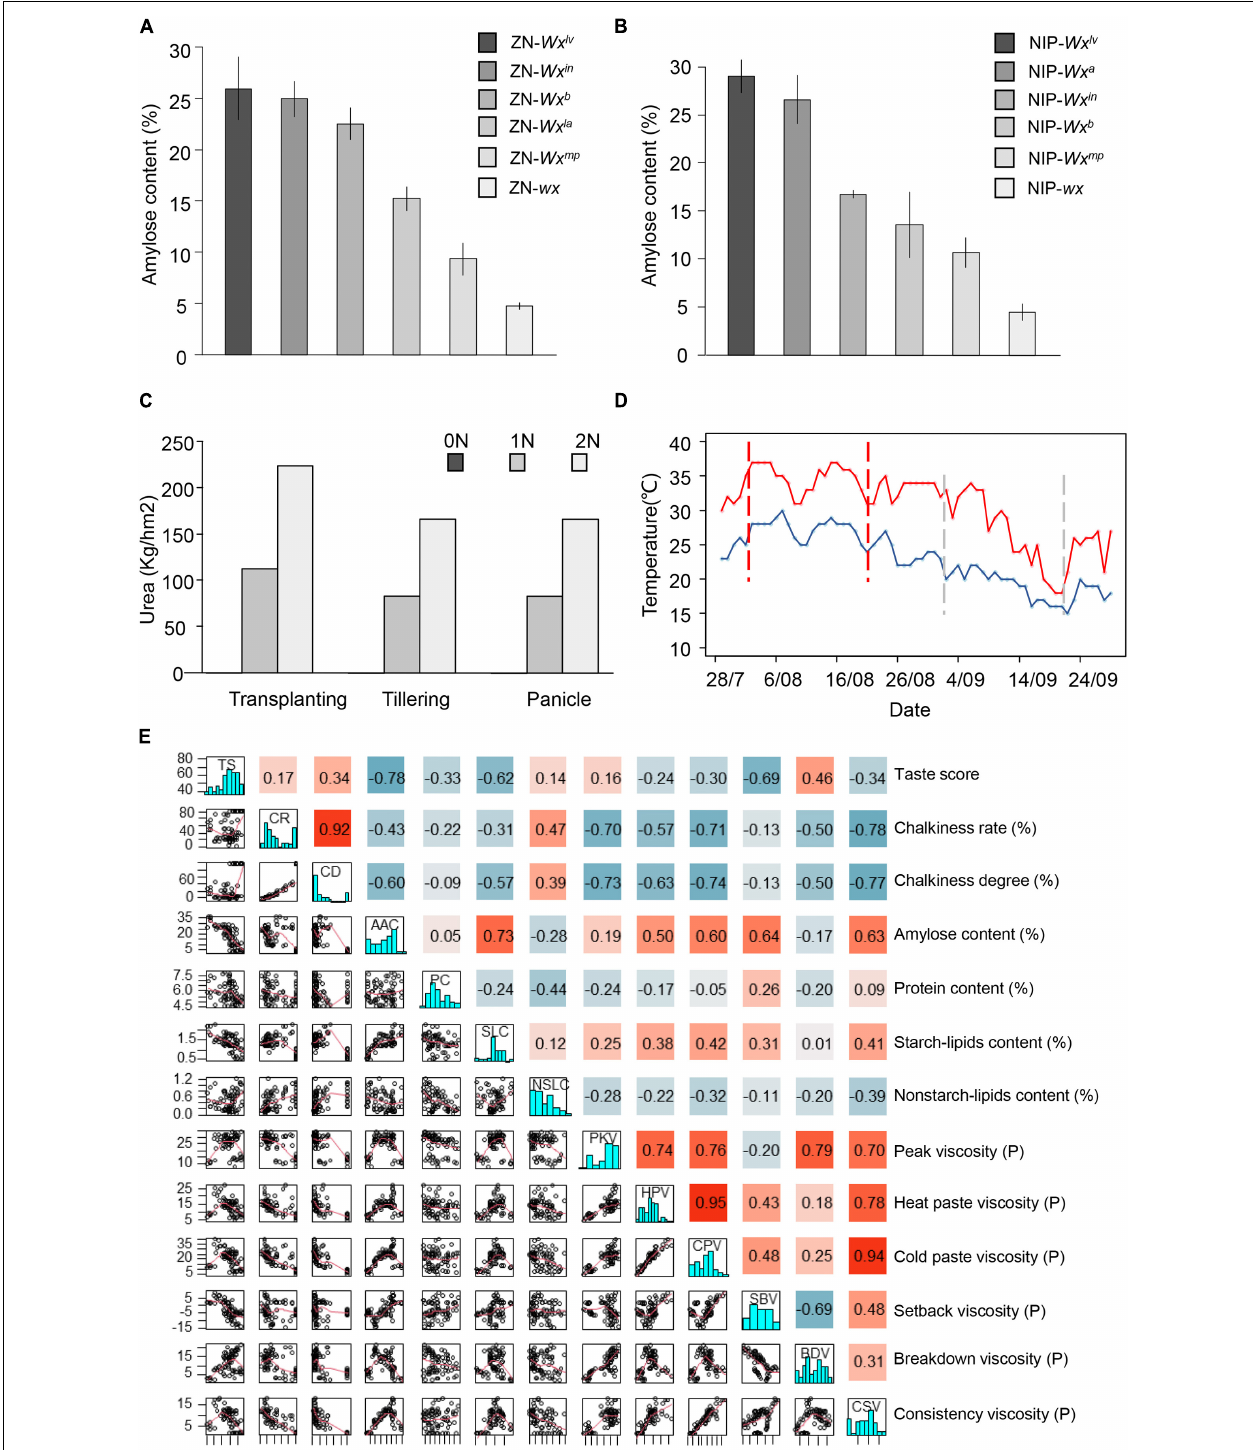
FIGURE 1 | Phenotypic analysis. (A,B) Grain amylose content (AC) transformants and near-isogenic lines (NILs). (C) The urea application density in field. (D) Profiles of the highest (red line) and the lowest (blue line) daily temperatures during grain filling of the rice lines. The space between the vertical dashed red lines represents the flowering period under high temperature (HT) conditions and the area between the vertical dashed gray lines represent the flowering period under low temperature conditions. (E) Correlation matrix among quality traits. P is short for Pascal, the unit of pressure.